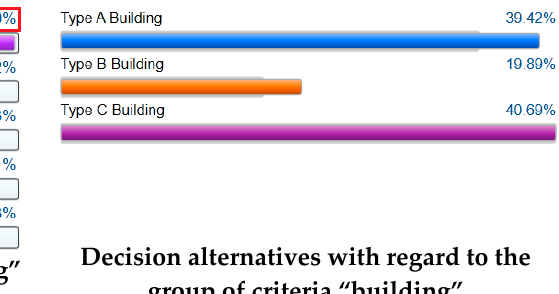
Figure 6. Relevance ranking (%) of sub-criteria of the group of criteria “building” with regard to the choice of adequate office space for BPO tenants with “building automation and IT services” ranked at 100%.